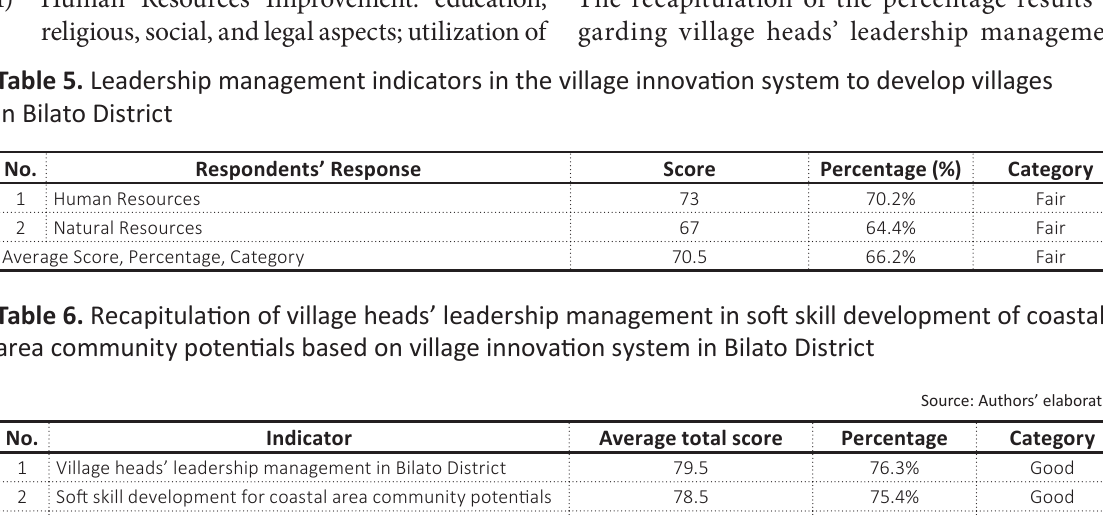
Table 5. Leadership management indicators in the village innovation system to develop villages in Bilato District